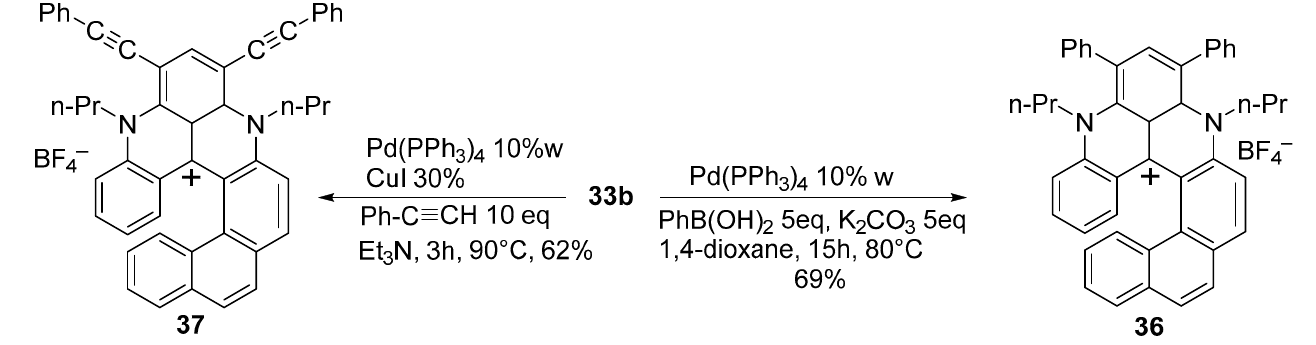
Scheme 29 . Introduction of aryl and alkynyl groups by the substitution of bromine.